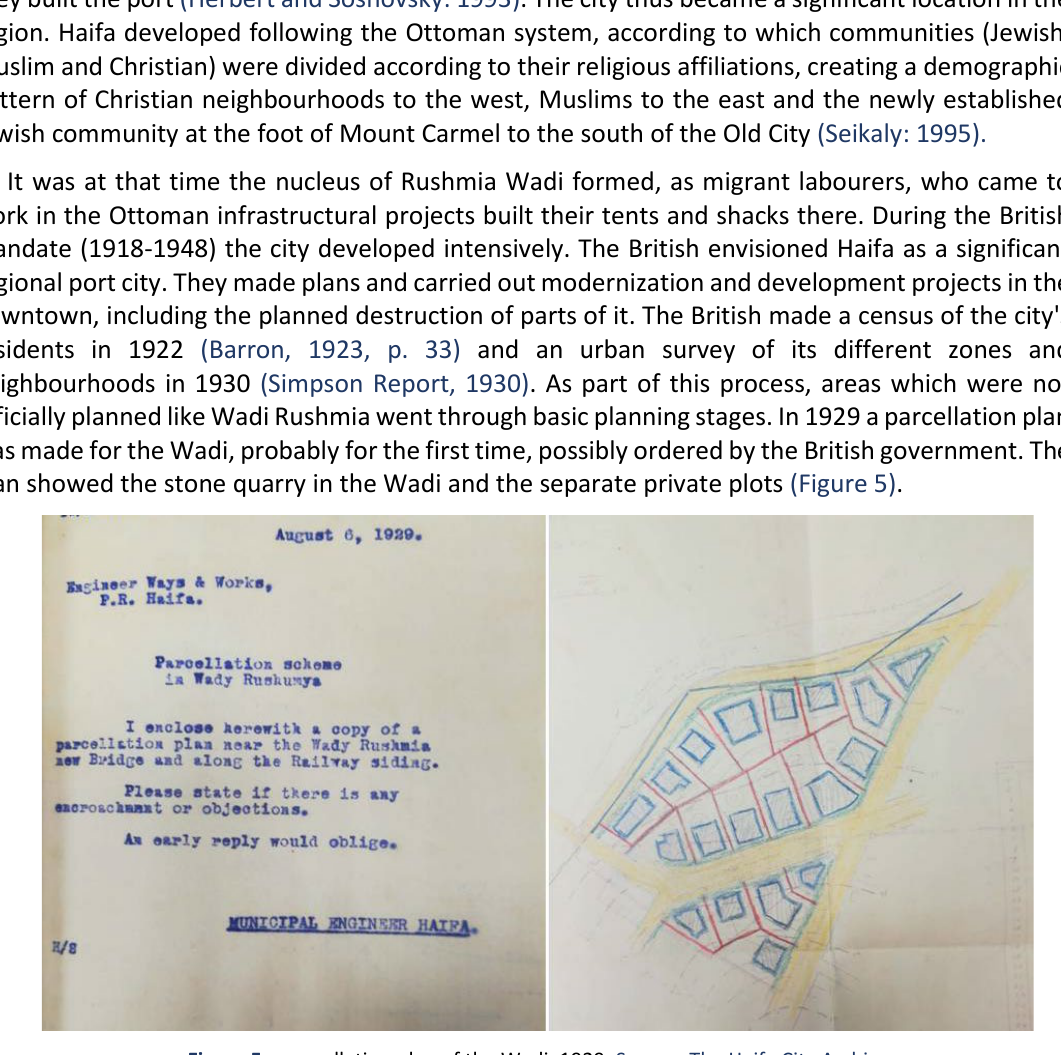
Figure 5 a parcellation plan of the Wadi, 1929, Source: The Haifa City